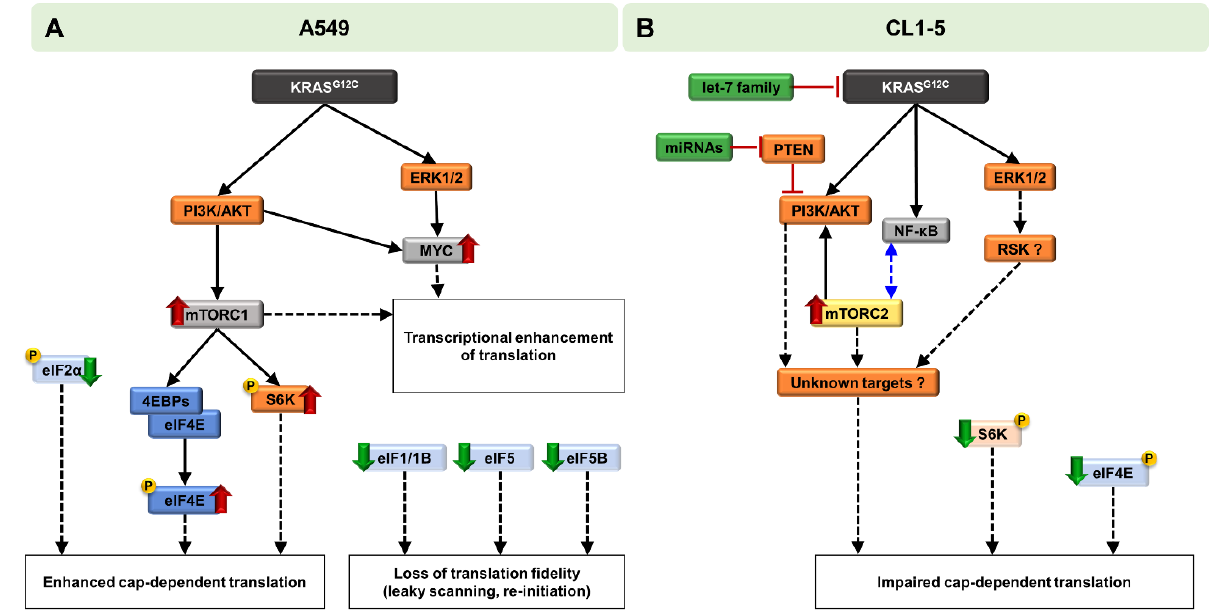
Figure 5. Schematic representation of the differential KRAS G12C -mediated oncogenic signaling and modulation of translation. ( A ) In A549 cells, expression of KRAS G12C mediates its oncogenic signaling through the MAPK and PI3K/AKT/mTORC1/p70S6K signaling pathways. Downstream targeting of 4E-BPs and eIF4E, along with the hypophos- phorylation of the eIF2 α subunit, leads to enhanced cap-dependent translation. Downregulation of eIF1, eIF5 and eIF5B is possibly associated with loss of translation fidelity during scanning of the mRNA, while recruitment of c-MYC, along with activated mTORC1, further promotes translation at the transcription level. All these events lead to promotion of translation and enhanced cell proliferation. ( B ) In CL1-5 cells, expression of KRAS G12C leads to activation of both MAPK and PI3K/AKT signaling pathways. PI3K axis activation is further enhanced by targeting of tumor-suppressor PTEN by miRNAs, while the tumor-suppressor let-7 family of miRNAs is upregulated due to a possible stress response mechanism. Interestingly, mTORC2 formation is promoted and is possibly correlated with the activation of NF- κ B. Downstream transcriptional and translational events, with participation of unidentified effectors, which could involve the ERK1/2-targeted RSK (Ribosomal S6 Kinase), along with the hypophosphorylation of both p70S6K and eIF4E, lead to impairment of cap- dependent translation.